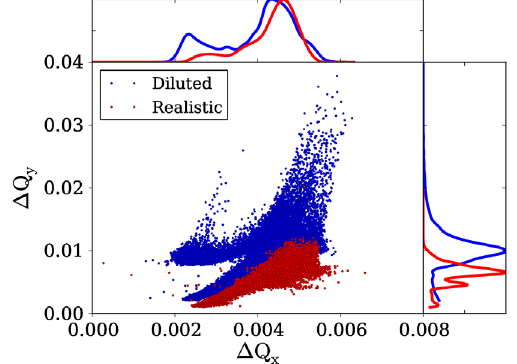
FIG. 11. Tune spreads for LHC-type bunch in a round pipe geometry with magnetic field. The blue dots represent the tune distribution induced by the diluted cloud. The red dots corre- spond to the tune distribution induced by the nonuniform cloud. ¼ 10 11 and the SEY δ ¼ 2 . 1 . The bunch population is N i max